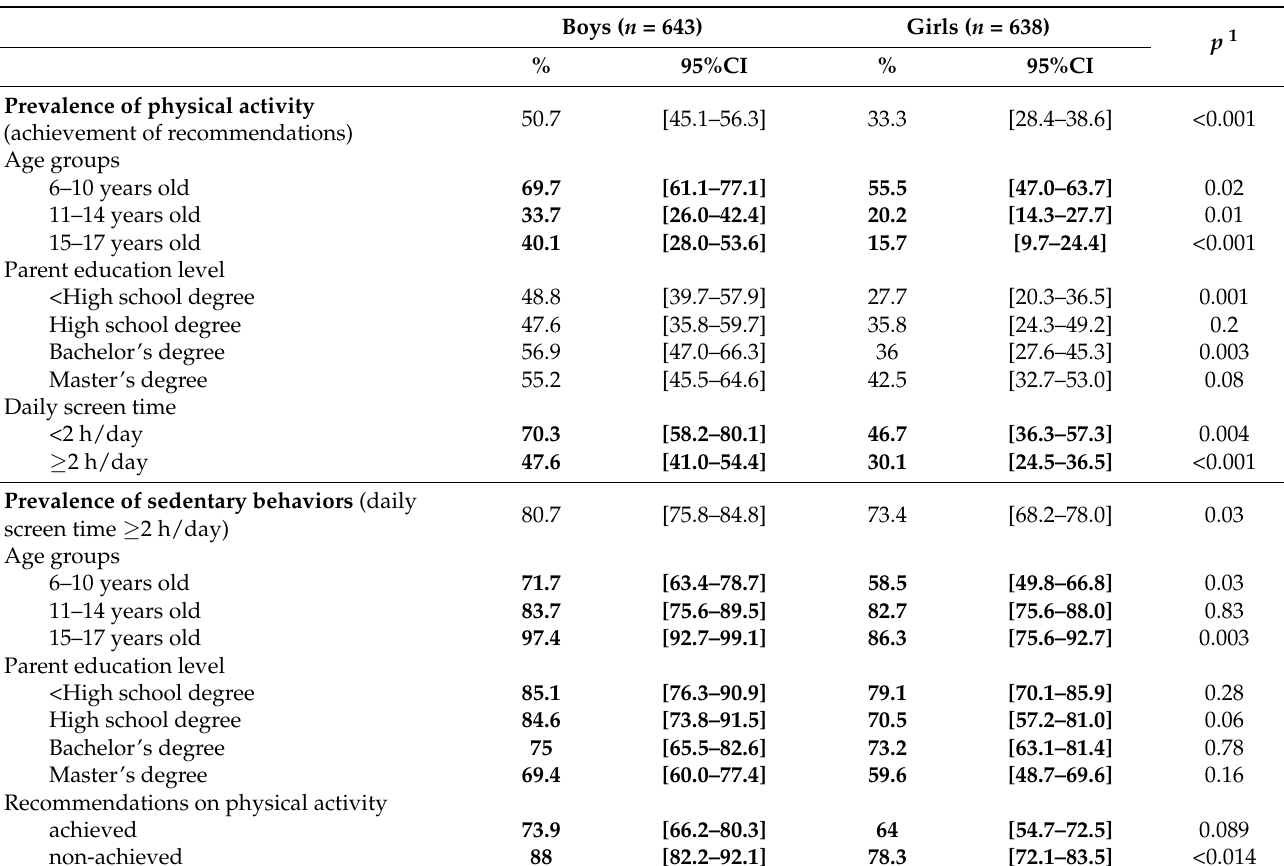
Table 3. Prevalence of physical activity and sedentary behaviors in children (6–17 years old) in the Esteban study